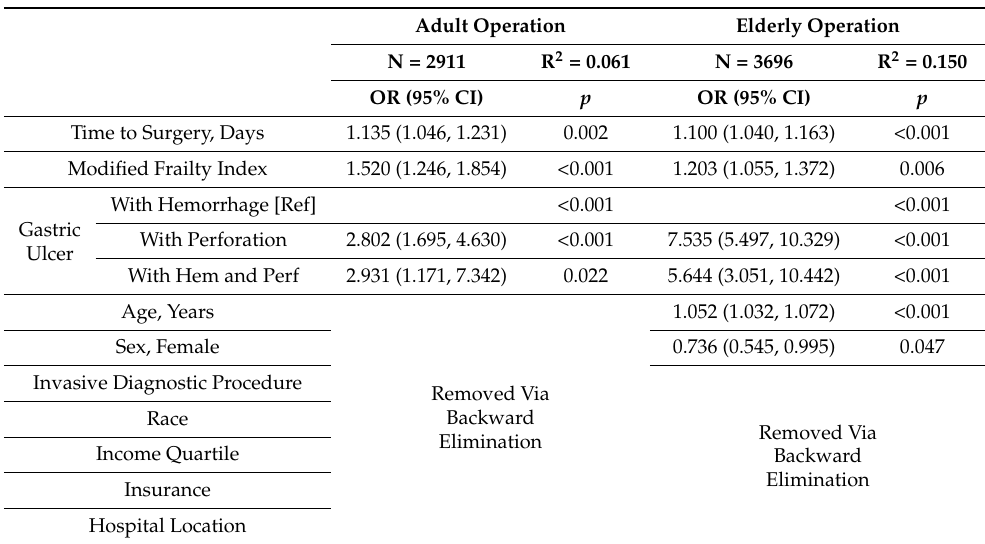
Table 5. The outcome of the backward logistic regression analysis to evaluate associations between mortality, which was the dependent variable, and various factors is presented in this table. The groups analyzed here were only those that elected an operation/surgery. Data were supplied by NIS 2005–2014.